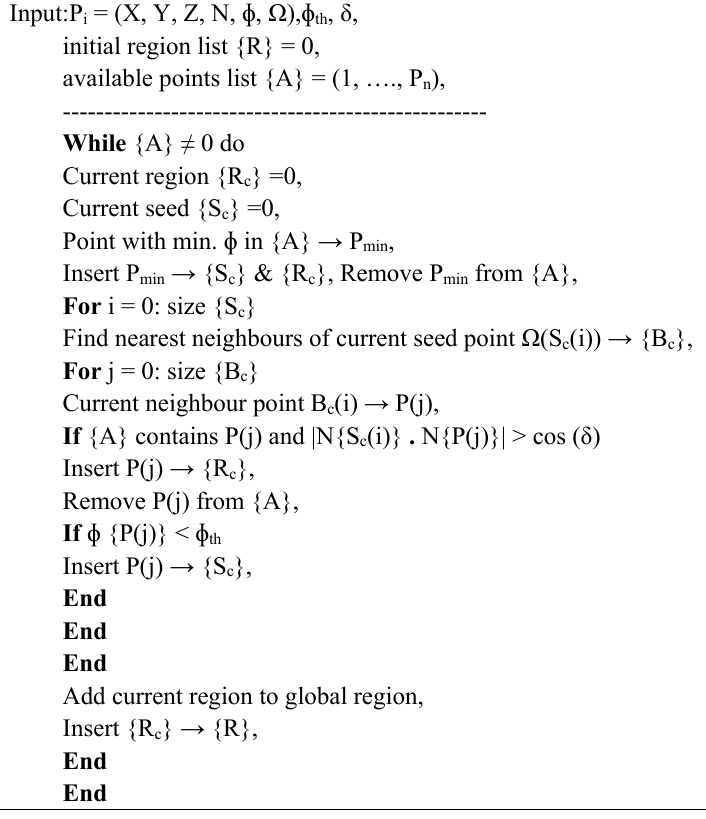
Table 2. The developed segmentation